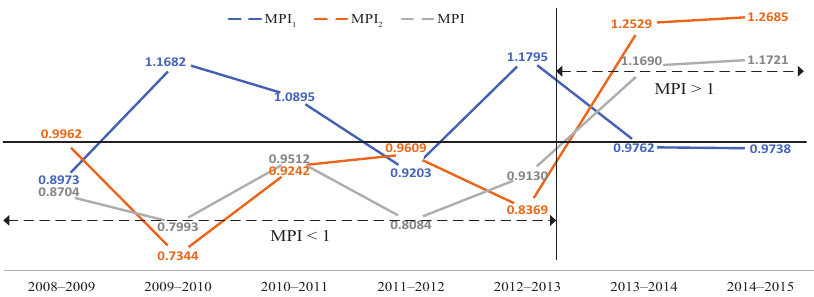
Figure 7. The line graph of the average common-weight global MPI and its decomposition from 2007 to